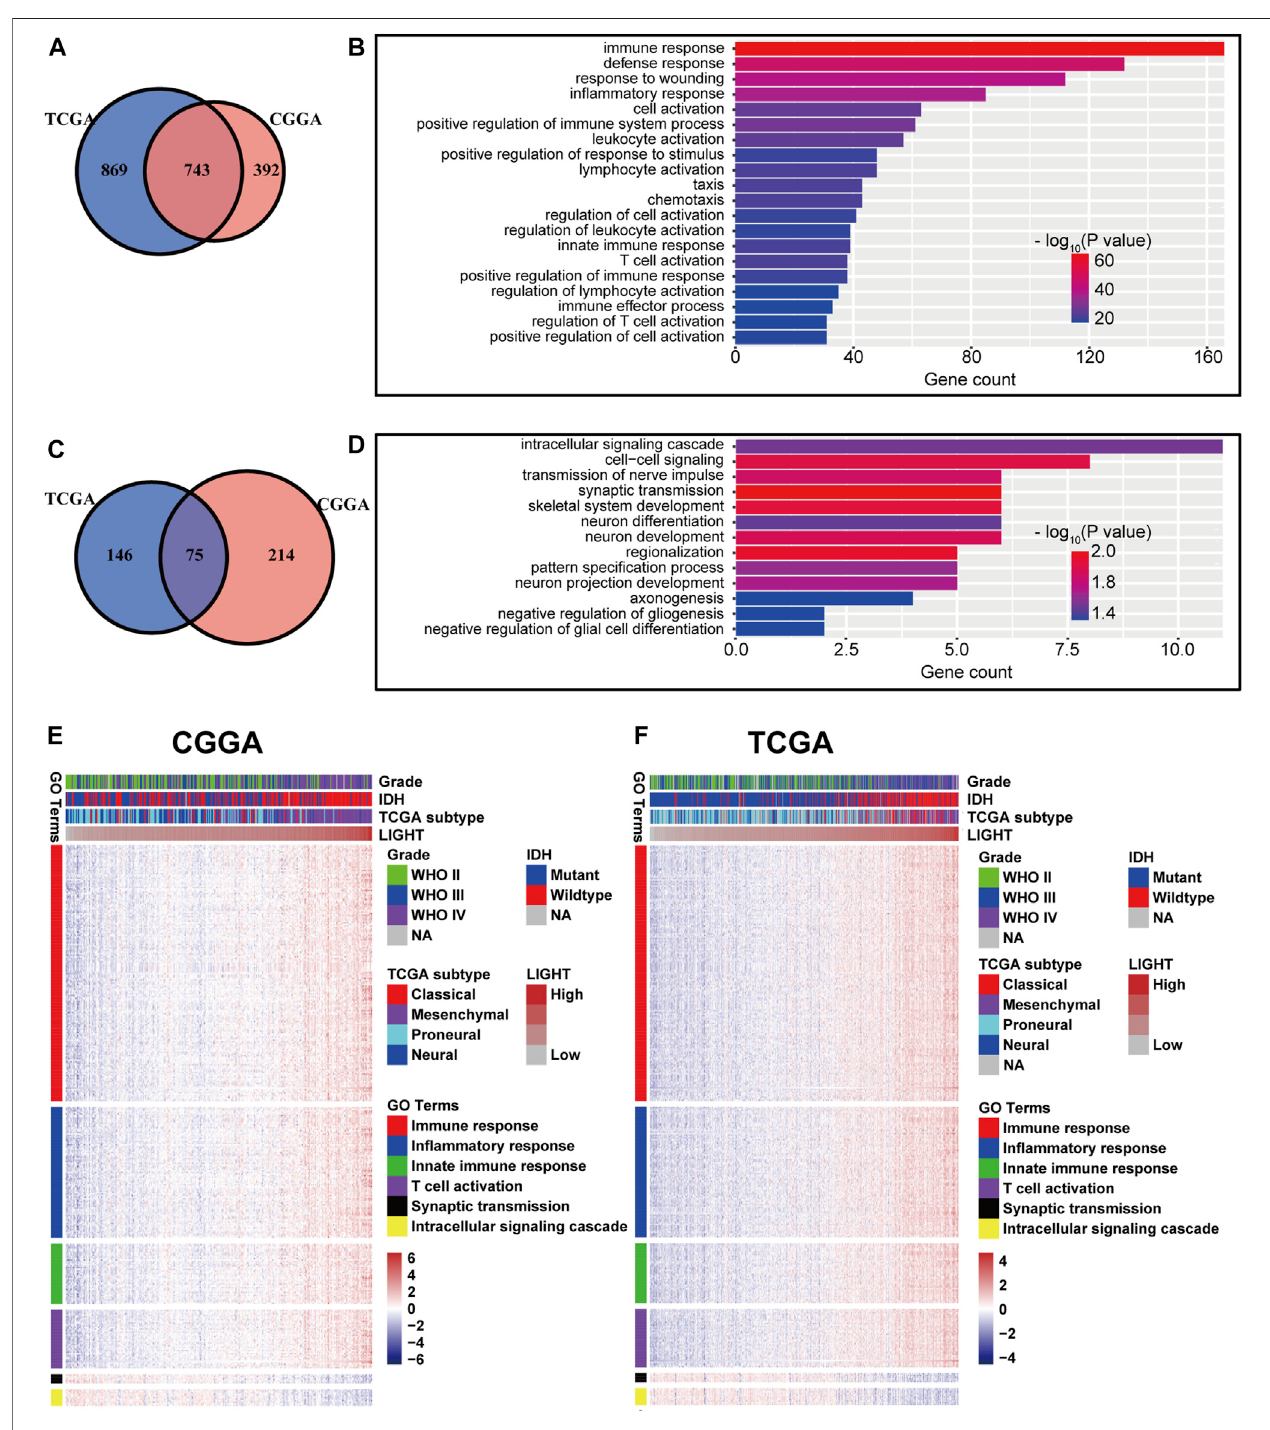
FIGURE 2 | Gene Ontology analysis for LIGHT in pan-glioma. Number of LIGHT positively correlated genes (A) and corresponding biological processes (B); number of LIGHT negatively correlated genes (C) and corresponding biological processes (D) ; clusters of GO terms of LIGHT highly related genes in the CGGA (E) and TCGA (F)